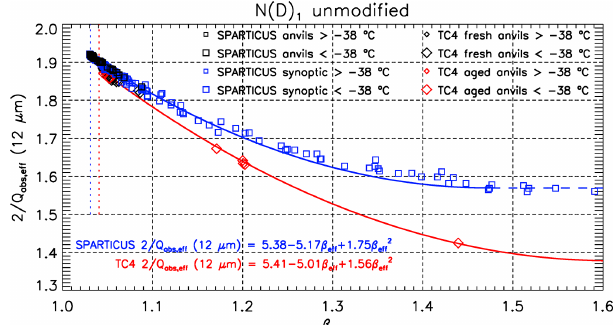
Figure 4. The β eff dependence of the term that converts the absorp- tion optical depth τ abs into visible optical depth in Eq. (7), based on PSDs from SPARTICUS synoptic cirrus (blue squares) and anvils (black squares), and TC4 aged (red diamonds) and fresh (black dia- monds) anvils, where the first size bin is included ( N(D) 1 unmodi- fied). The larger (smaller) symbols denote PSDs measured at a tem- perature colder (warmer) than − 38 ◦ C. The curve-fit equations are for SPARTICUS synoptic cirrus (blue) and for TC4 aged and fresh anvils (red). The dashed lines are where the curve-fit equations are extrapolated (see Table 1).